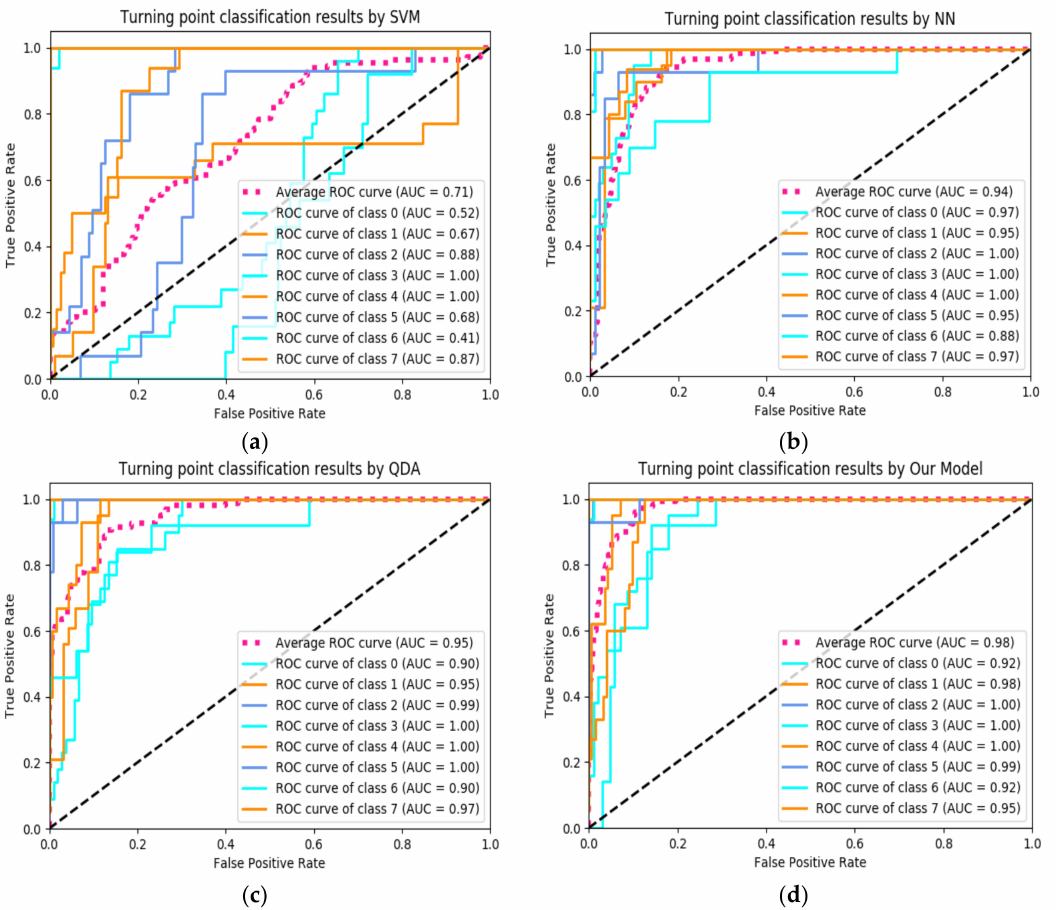
Figure 10. Performance comparison of common machine learning classifiers: ( a ) Classification Performance of Support Vector Machine (SVM); ( b ) Classification Performance of Neural Networks (NN); ( c ) Classification Performance of Quadratic Discriminant Analysis (QDA); and ( d ) Classification Performance of our